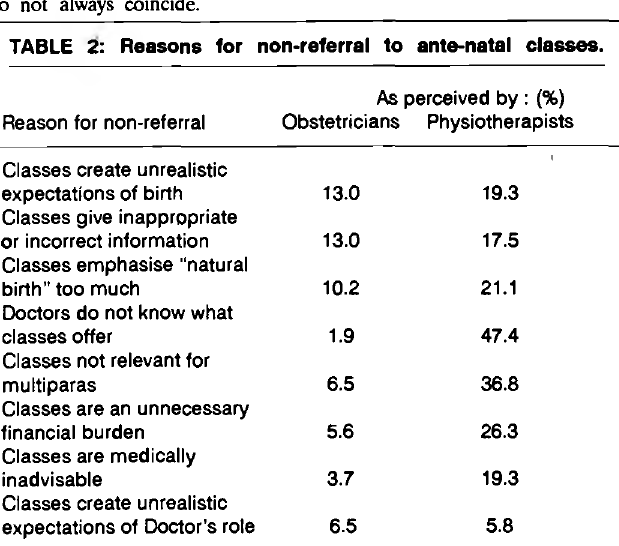
TABLE 1 : Perceptions of obstetricians and of physiotherapists of referral